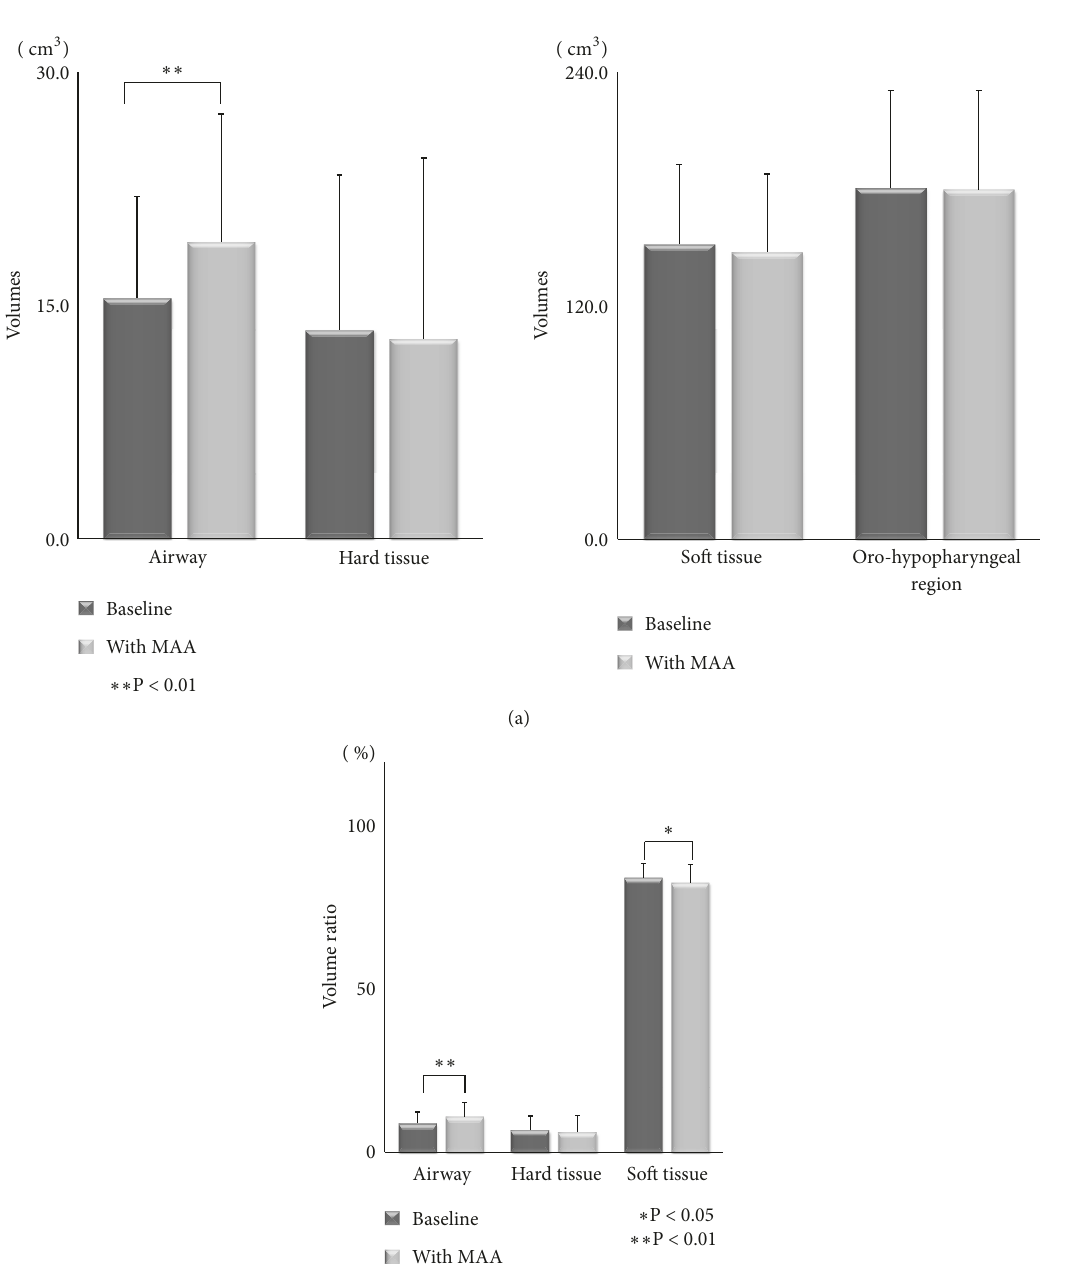
and collapsibility of the upper airway, which was observed by MSCT in the experimental area. It might not be critical to evaluate the full net volume of the soft tissue. In our opinion, the anatomical balance is more important; this means that not just the airway size, but also the surrounding hard and soft tissue volume is involved in OSA. That is the reason why we calculated and evaluated the ratio of soft tissue volume against the oro-hypopharyngeal